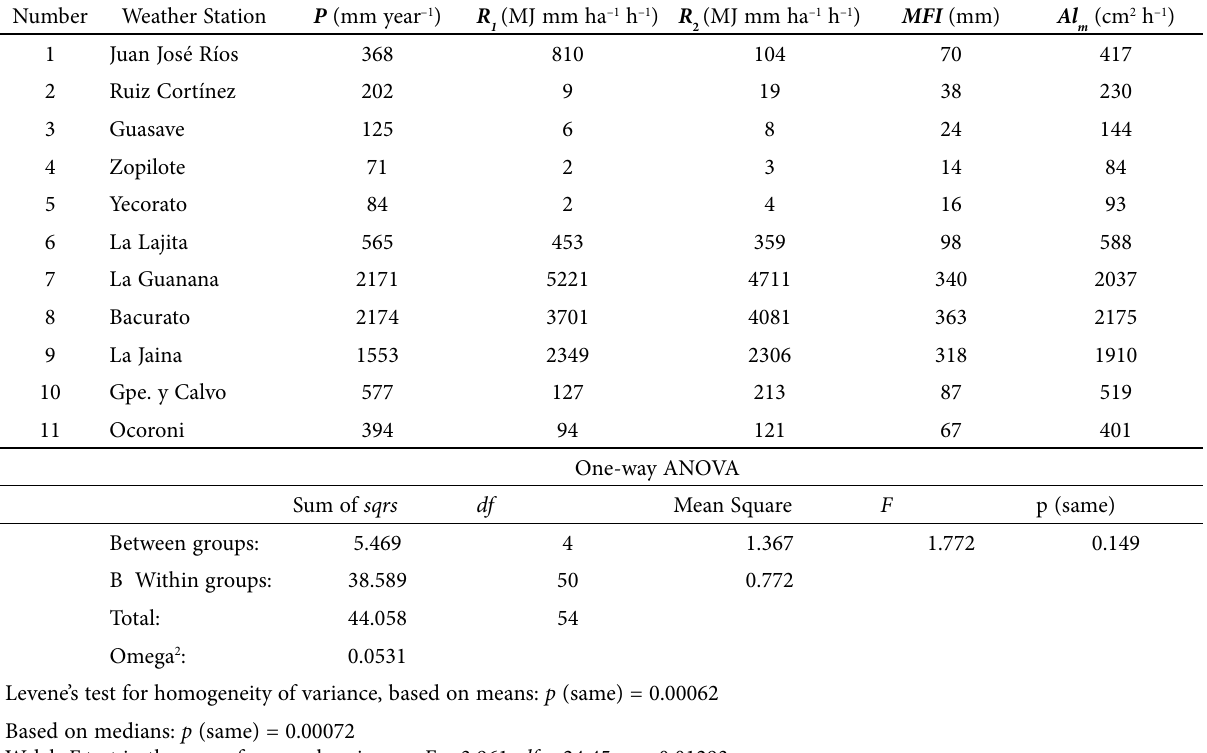
(MJ mm ha –1 h –1 ), R 1 2